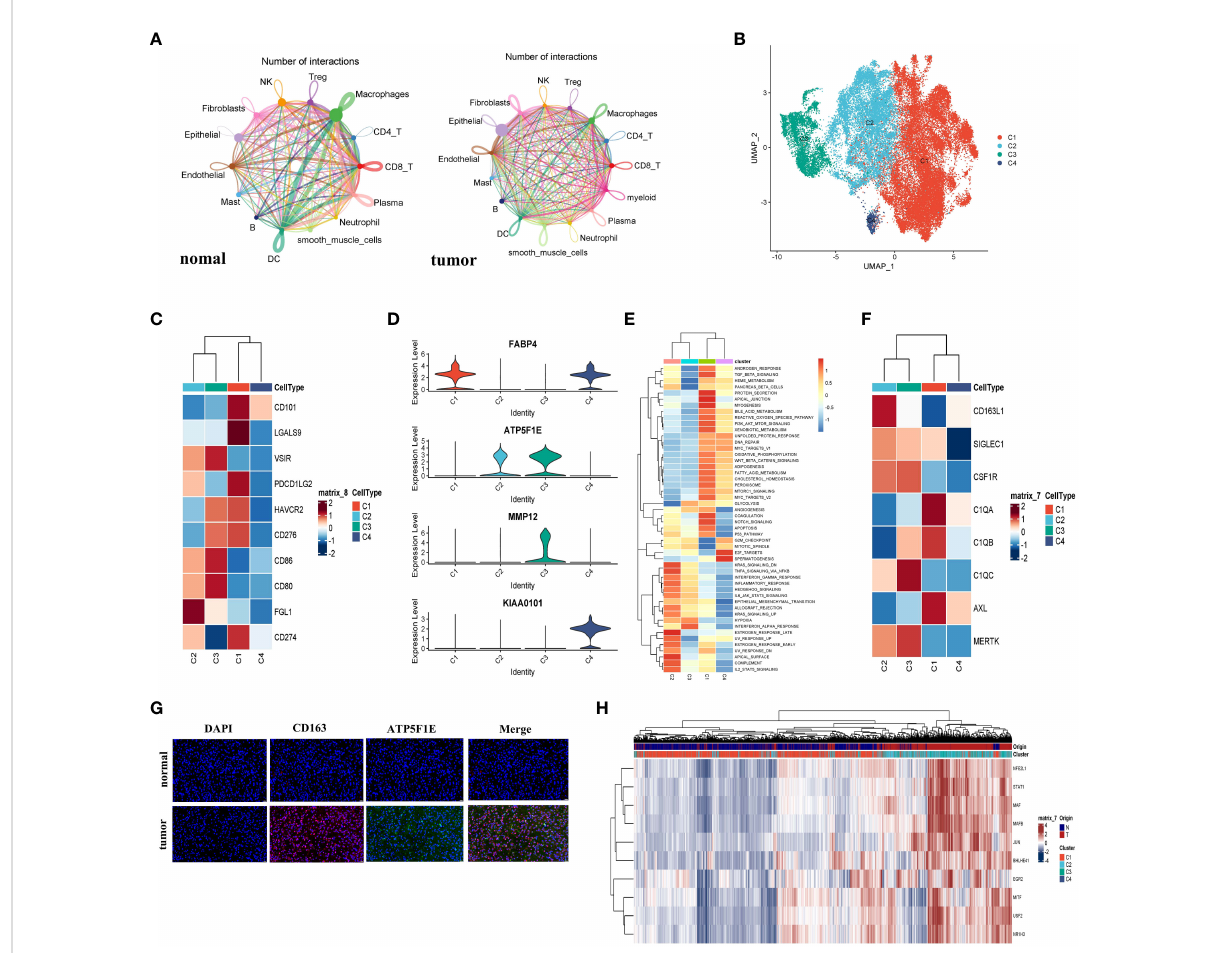
FIGURE 2 The macrophage cells demonstrated M2b polarization in LUAD. (A) The cell interaction network generated by CellChat; normal and tumor (left to right); the nodes size and color represented the counts of interaction; the larger size and brighter color correspond to more frequent interactions for different cell types. (B) The UMAP plot showed all four types of macrophage cells. (C) The heatmap showed the expression level of the immune checkpoint gene on macrophages and represented by a row Z score. (D) Violin plots of marker genes for four subgroups. (E) The Heatmap demonstrated the expression of the famous M2-like TAM markers. The expression level of the cell cluster was represented by a row Z score. (F) Immuno fl uorescence staining analyzed the expression of CD163 and ATP5F1E in LUAD or normal specimens. The CD163+ ATP5F1E+ macrophages exclusively appeared in tumor specimens. The scale bar represented 20µm. (G) The heatmap showed the differences in the activities of 50 hallmark pathways using GSVA. (H) The heatmap showed the differences in expression regulation by transcription factors, and the AUC scores were estimated by